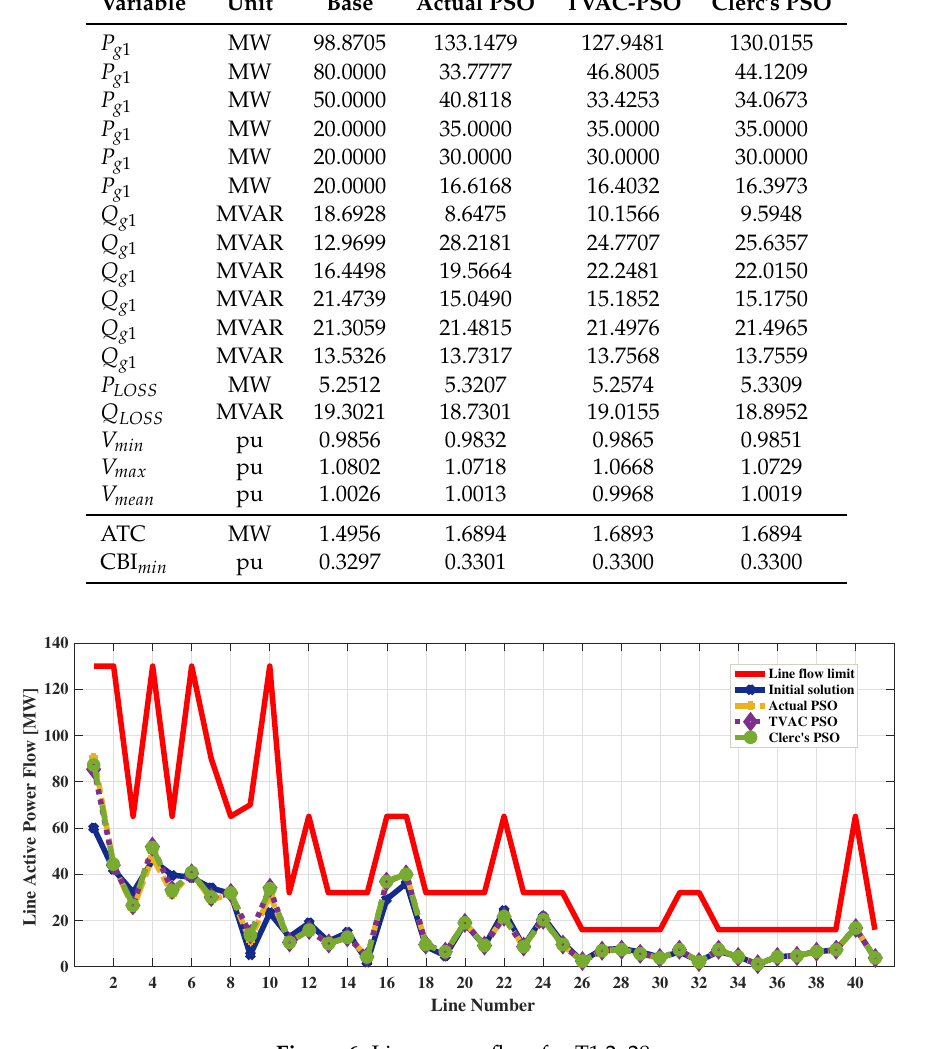
Figure 6. Line power flow for T1:2–28. Table 4. Ten critical lines considering voltage stability limit (CBI) for T1: